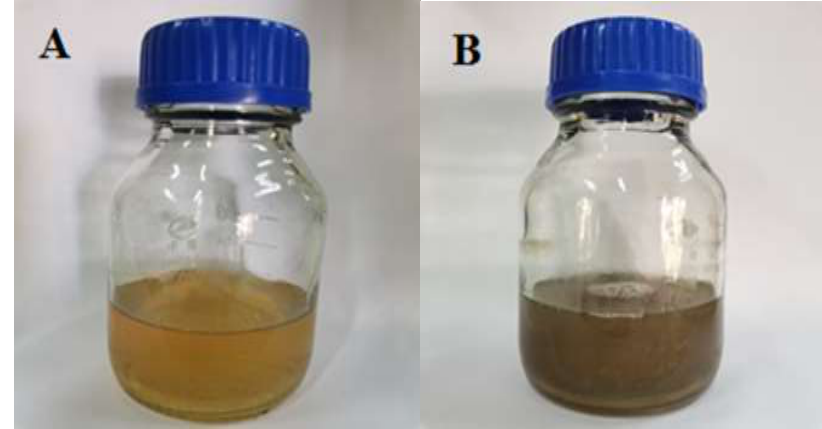
Figure 3: Stages of the synthesis of silver nanoparticles, (A) at zero time, (B) after 48